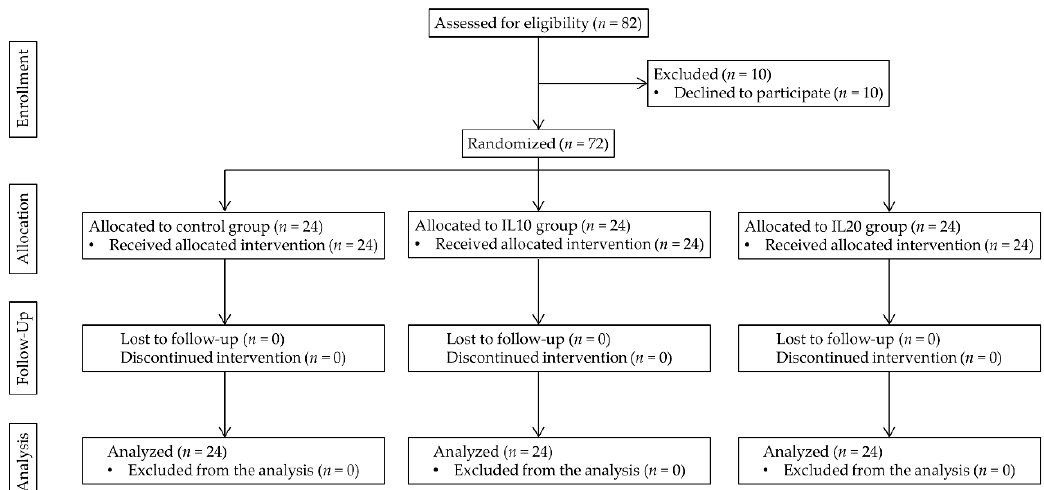
Figure 1. Consolidated Standards of Reporting Trials (CONSORT) flowchart of the study.